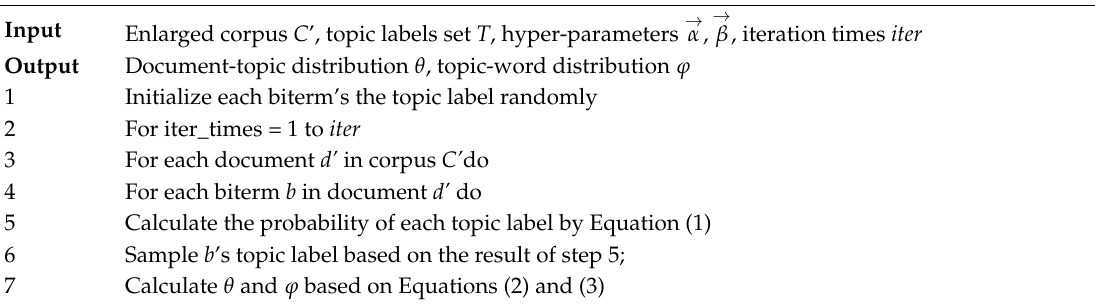
Algorithm 1 Gibbs Sampling